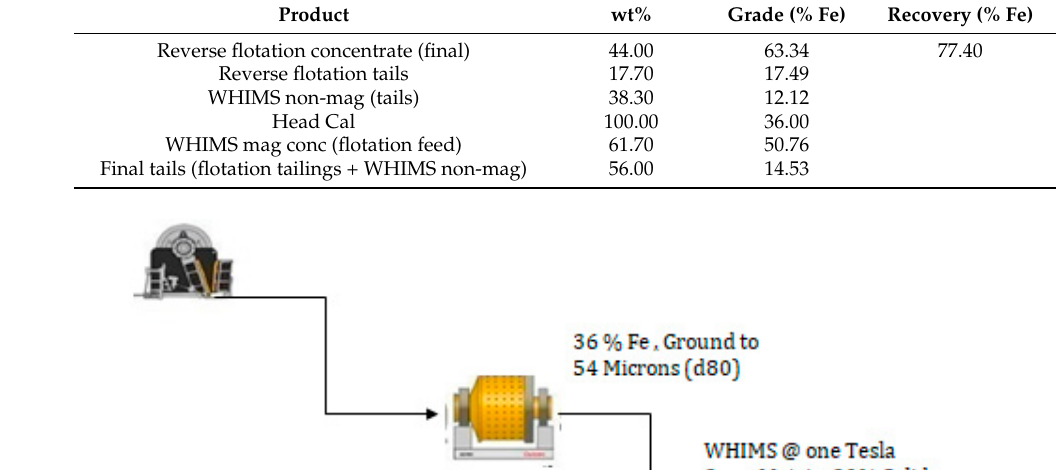
Figure 7. Final process flowsheet for processing BHQ. Table 10. Final test with WHIMS followed by flotation of WHIMS concentrate.